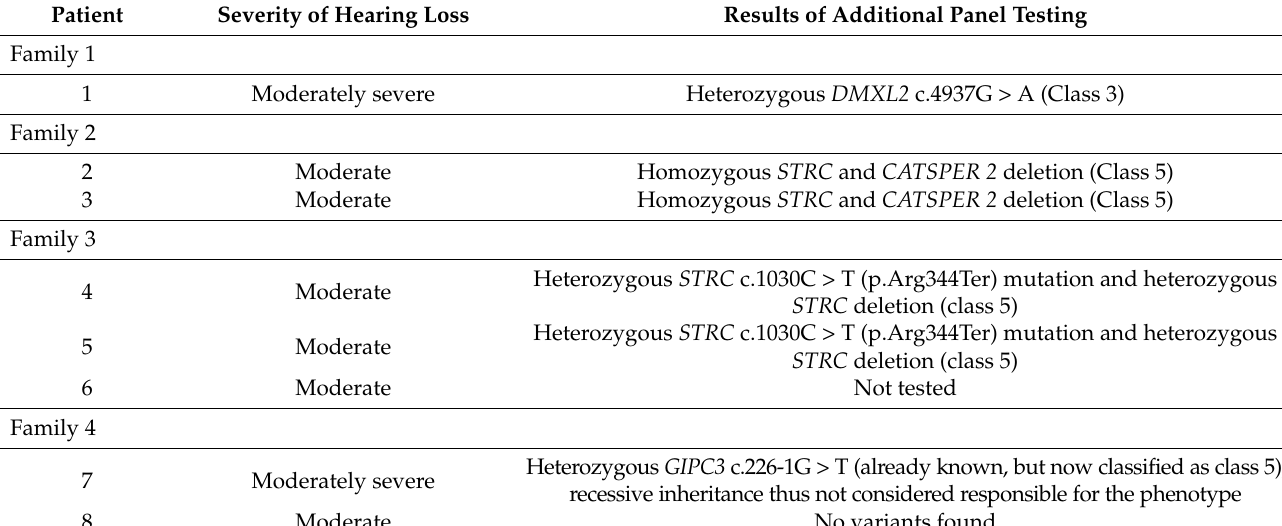
Table 2. Results of additional whole exome sequencing-based panel